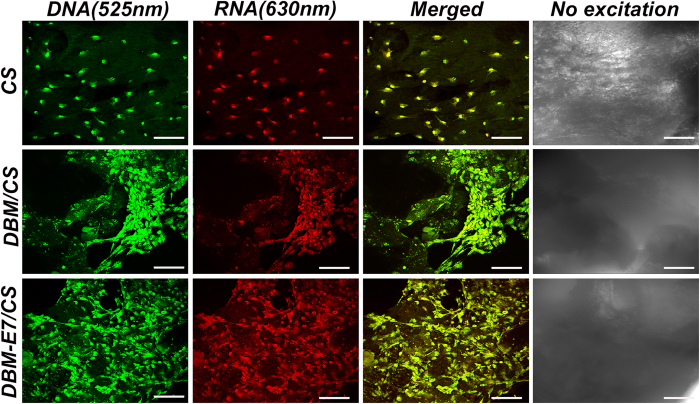
Morphology, adhesion, and distribution of BMMSCs grown on the three scaffold groups.BMMSCs grown on the three scaffold groups were uniformly stained with green and red fluorescence. Green: intercalated DNA by AO with fluorescence at 525 nm. Red: electrostatic RNA by AO with fluorescence at 630 nm. Yellow: combination of green and red above. No excitation: the bright field. Scale bar = 100 μm. Magnification: ×25.